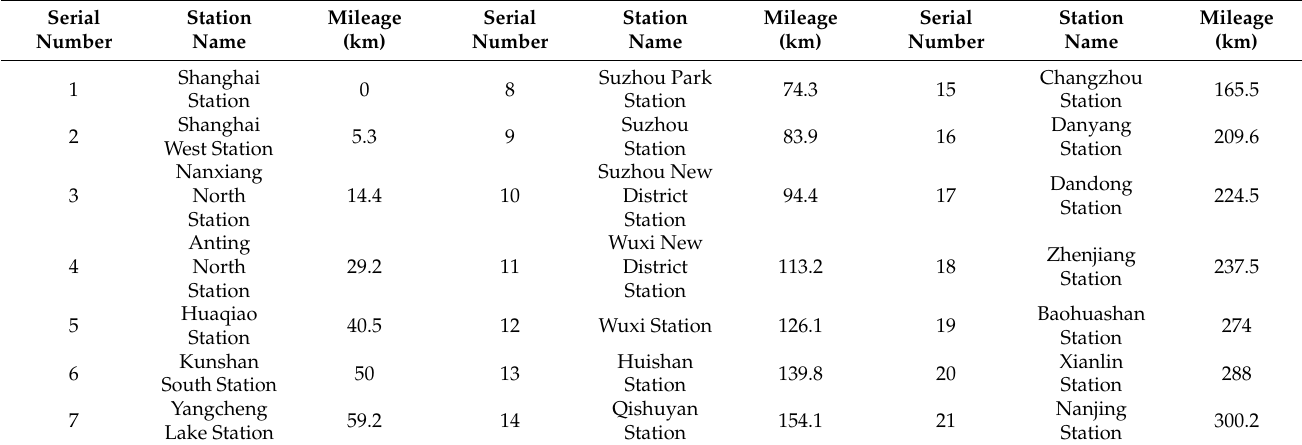
Table 1. Shanghai–Nanjing intercity railroad line data.